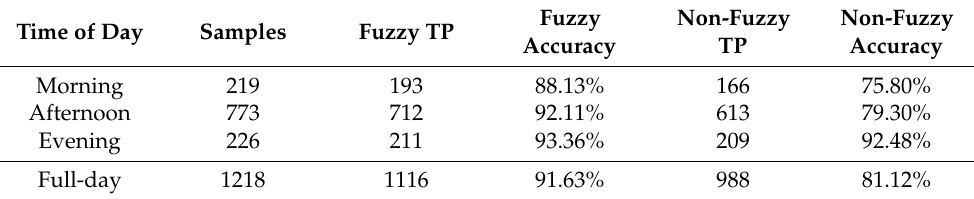
Fuzzy Non-Fuzzy Non-Fuzzy Accuracy TP Accuracy